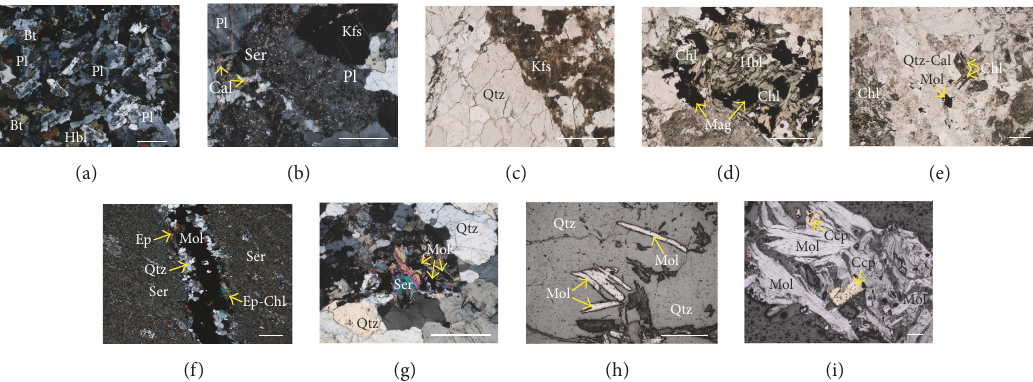
Figure 3: Representative photomicrographs from the Haisugou Mo deposit showing the alteration and mineralization in different hydrothermal stages. (a) Photomicrograph of the Haisugou granite showing the major phenocryst minerals. (b) Plagioclase of the granite alteredtosericiteandcalcite.(c)P-stagebarrenquartzveinsurroundedbyK-feldsparhalos.(d)Hornblendeofthegranitealteredtomagnetite andchlorite.(e)S-stagequartz-calcite-molybdeniteveinwithchloritehalos.(f)S-stagequartz-molybdenite-chlorite-epidoteveinwithsericite halos. (g) S-stage molybdenite-quartz-sericite vein. (h) Molybdenite flakes in S-stage quartz vein. (i) Molybdenite flakes and chalcopyrite in S-stage breccia ores. (a), (b), (f), and (g) were taken under crossed polarized light, (c), (d), and (e) under plane polarized light, and (h) and (i) under reflected light. The scale bar is 0.5 mm in each photomicrograph. Bt: biotite; Cal: calcite; Ccp: chalcopyrite; Chl: chlorite; Ep: epidote; Hbl: hornblende; Kfs: K-feldspar; Mag: magnetite; Mol: molybdenite; Pl: plagioclase; Qtz: quartz; Ser: